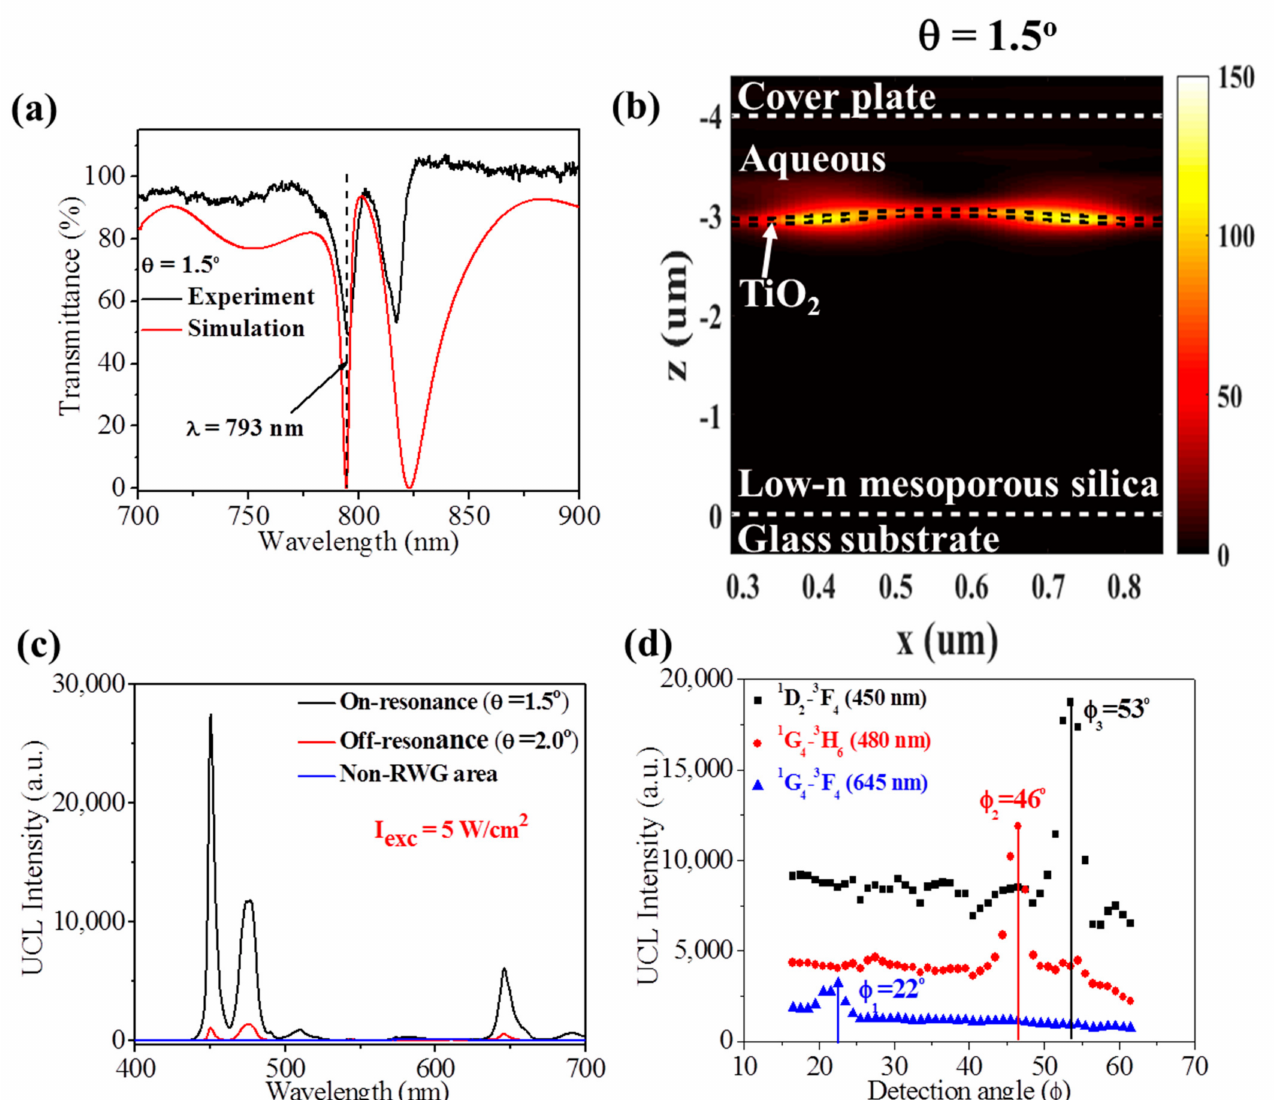
Figure 4. ( a ) Measured and simulated transmission spectra of the low − n RWG structure at the incident angle of 1.5 ◦ . ( b )Simulated TE mode electric − field intensities (| E | 2 ) under resonant excitation condition ( λ = 793 nm, θ = 1.5 ◦ ) of the low − n RWG flooded with aqueous solution. ( c ) UCL spectra measured at the RWG area of the low − n RWG deposited with CSS UCNPs under on − resonance ( θ = 1.5 ◦ ) and off − resonance ( θ = 2.0 ◦ ) and that measured at the non − RWG area of the sample. ( d ) UCL emission intensities at the characteristic emission peaks of the CSS UCNPs deposited on the top surface of the low − n RWG sample versus the detection angle ( φ ) under resonant excitation condition ( θ = 1.5 ◦